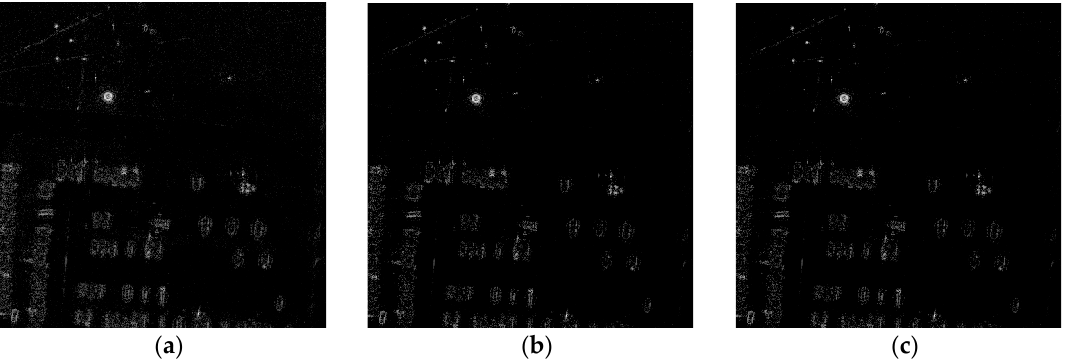
Figure 3. Images recovered from fully sampled X-band Gotcha Volumetric SAR data via different methods. ( a ) Matched filtering. ( b ) Raw data-based sparse imaging method. ( c ) Complex image-based sparse imaging method.